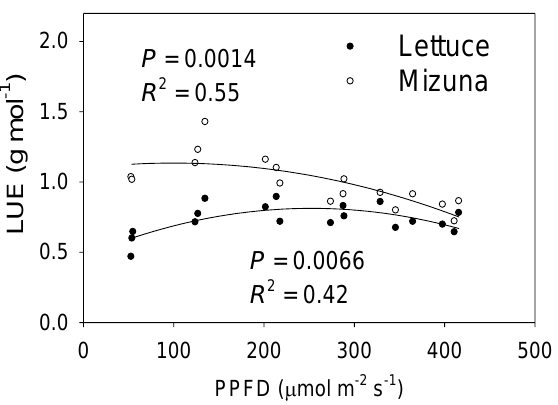
Figure 8. Light use efficiency (LUE, grams of shoot dry weight per mol of incident light) of mizuna ( Brassica rapa var. japonica) and lettuce ( Lactuca sativa ‘Green Salad Bowl’) plants grown at six different photosynthetic photon flux densities (PPFDs) for 27 and 28 days, respectively. Each data point represents the mean of nine plants.